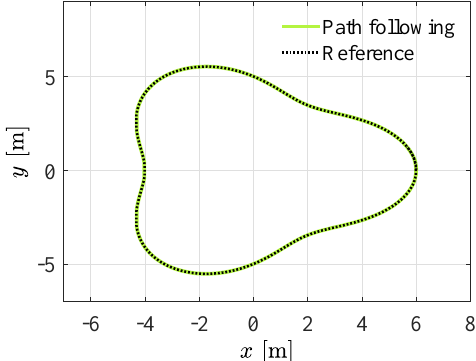
Figure 14. Trajectory tracking for the experiment 4.